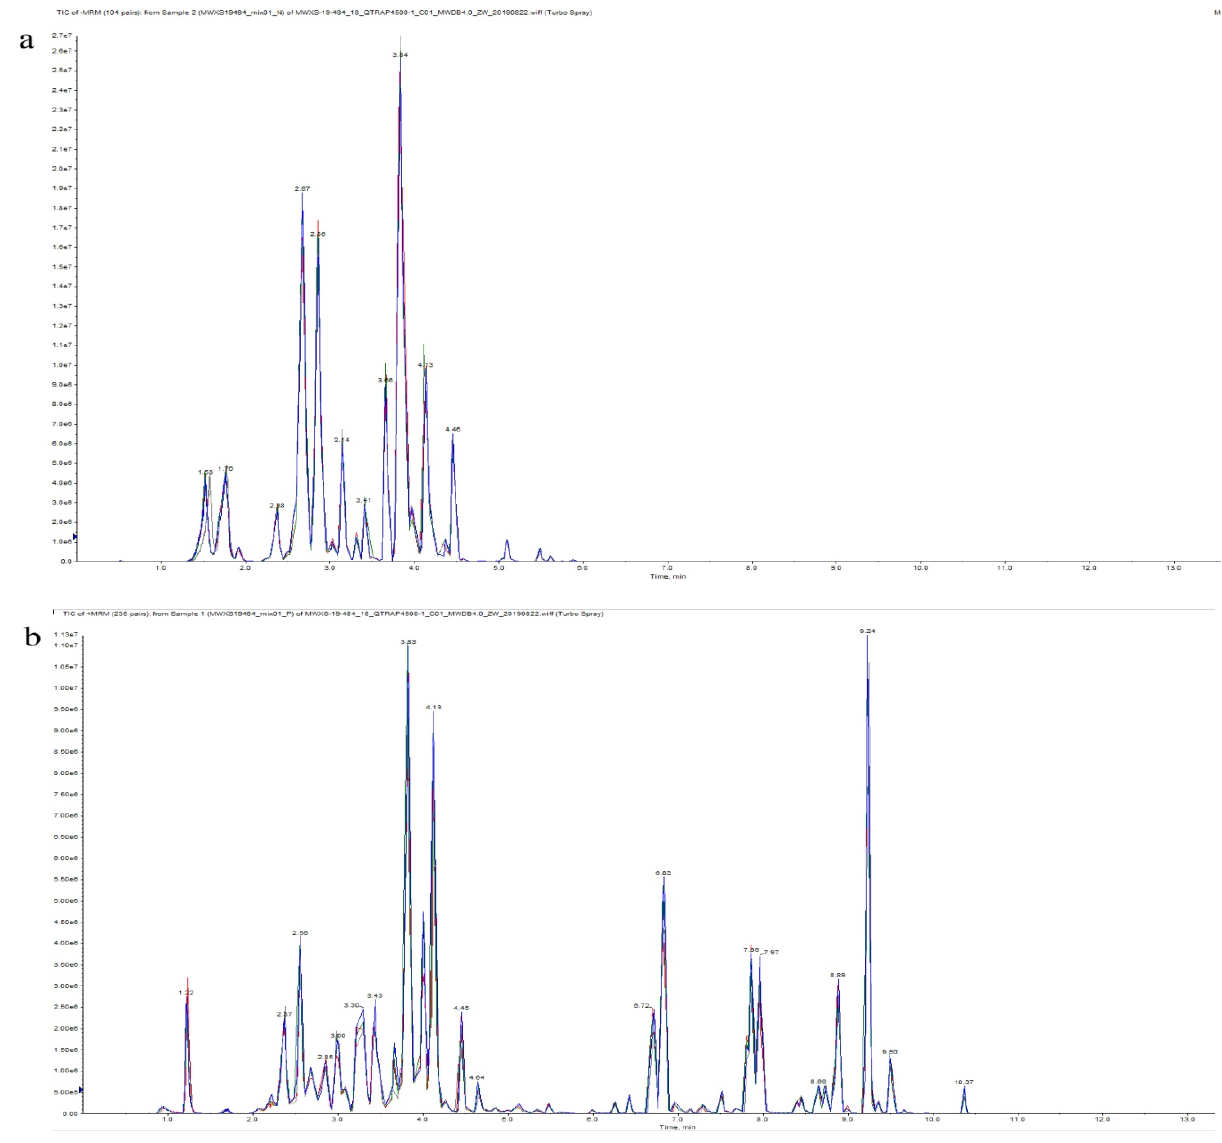
Figure 8. Mass spectrometry quality control (QC) total ion current (TIC) superposition diagram. ( a ) Diagram of TIC of negative-ion multiple reaction monitoring (MRM). ( b ) TIC of positive-ion MRM diagram.